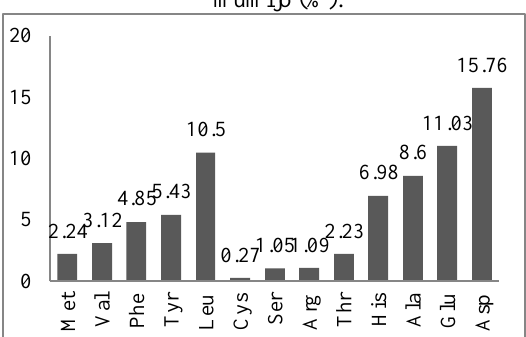
Fig 2. Content of protein amino acids in natural mumijo (%).